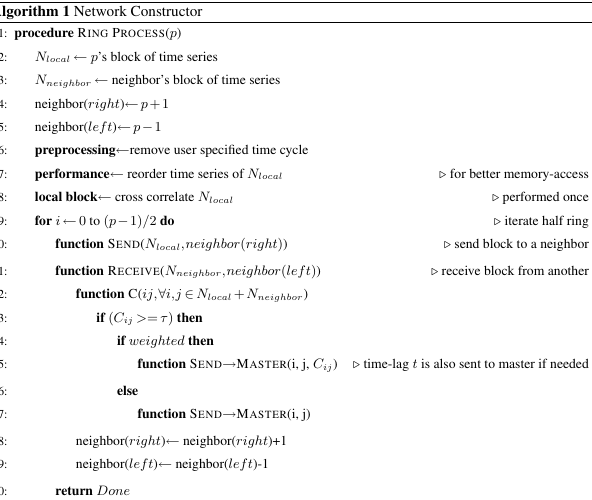
Algorithm 1 Network Constructor 1: procedure R ING P ROCESS ( p